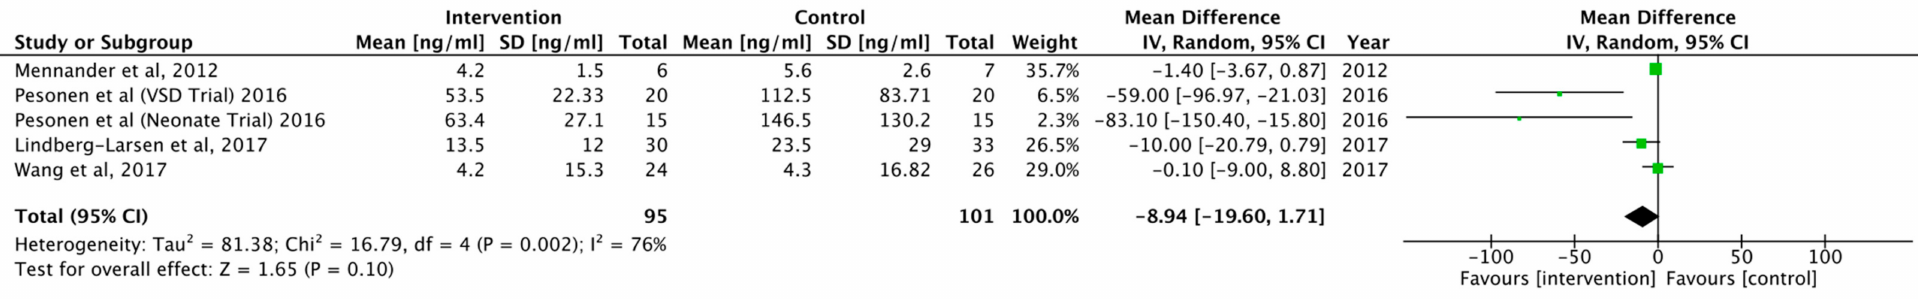
Figure 4. Forest plot of the mean difference of plasma syndecan-1 concentration changes for treatments to protect against EG degradation in